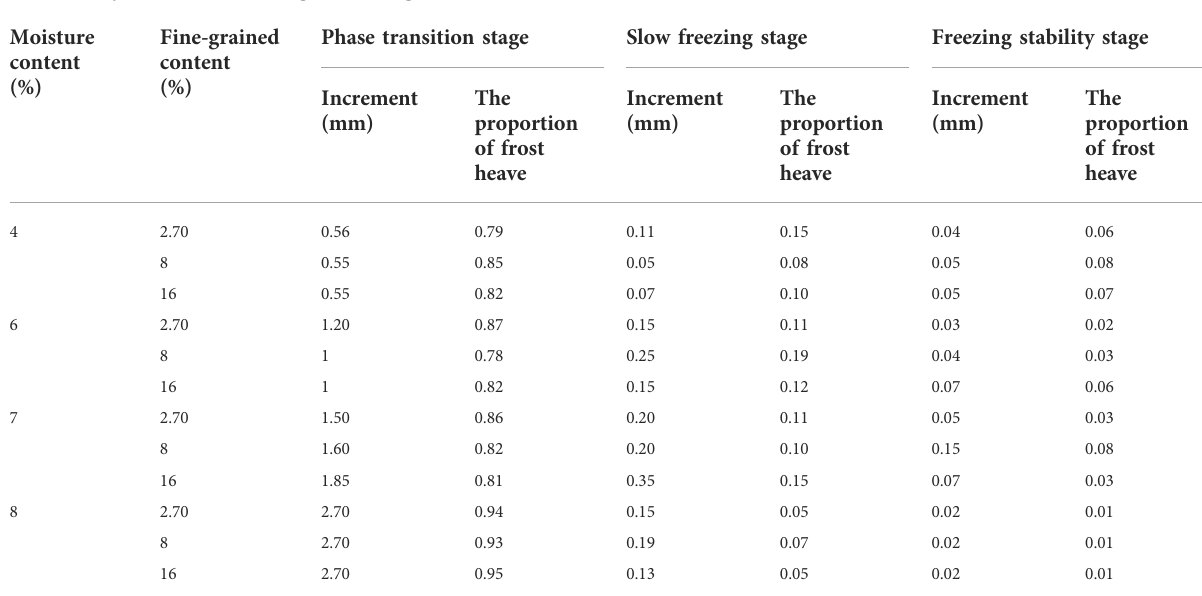
TABLE 4 Proportion of frost heaving in each